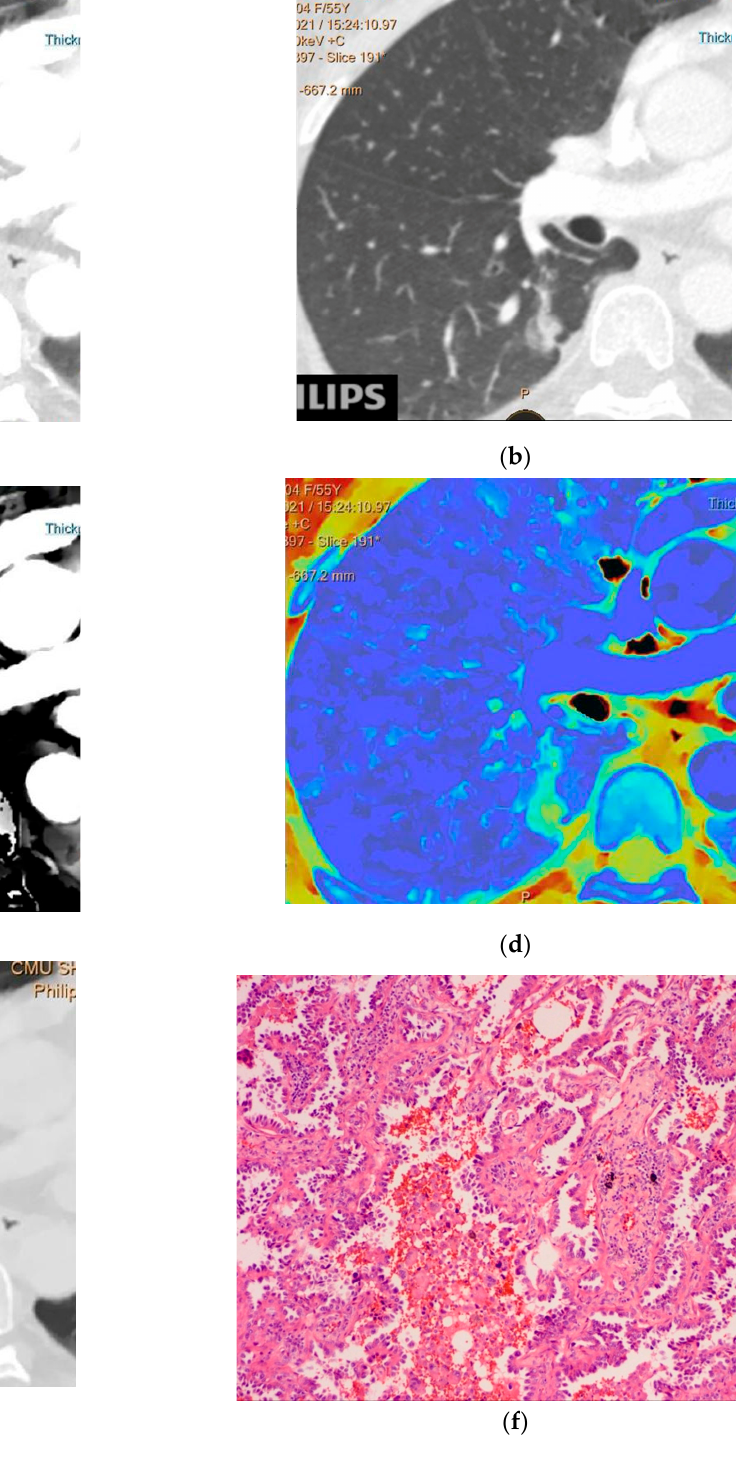
Figure 3. ( a ) CT40 keV, ( b ) CT100 keV, ( c ) iodine density map, ( d ) effective atomic number, and ( e ) electron density in the arterial phase. Spectral dual-layer detector-based computed tomography of a 55-year-old woman showing mGGN in the lower lobe of right lung, Daverage = 14.78 mm, CT40 keVa = − 141.7, CT100 keVa = − 223.8, IC (a) = 2.11, Zeff (a) = 8.19, and EDW (a) = 77.3. The postoperative pathology is invasive adenocarcinoma ( f ).